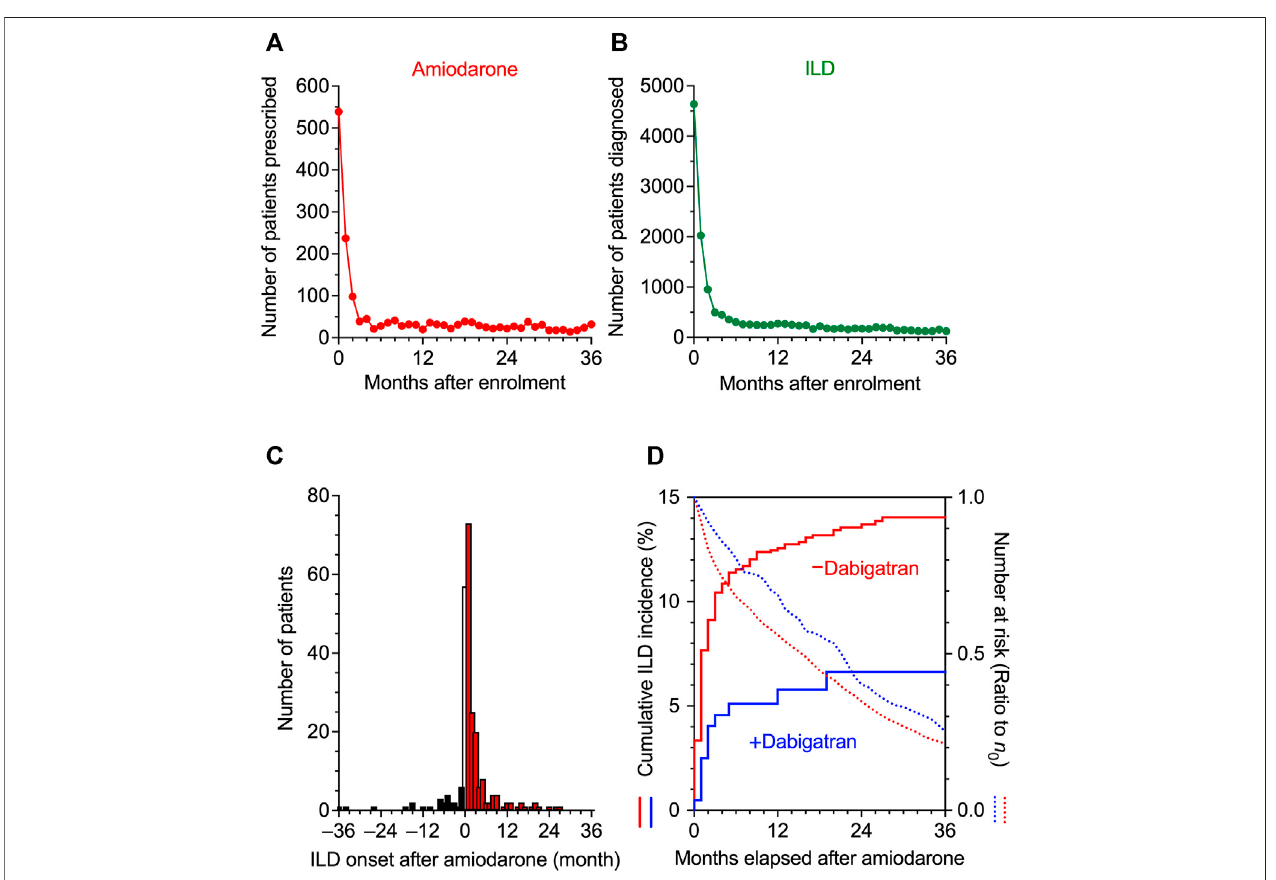
FIGURE2| Timedistribution oftheeventinJMDCclaims data. (A,B) ,Theintervalsfrom theinsuranceenrolmentofapatient tothe fi rstprescription ofamiodarone (A) and to the initial diagnosis ofinterstitial lung disease (ILD) (B) were analyzed, and the number of patientsis shown on a monthly basis. From these data, patients who hadbeenenrolledinhealthinsurancefor0 – 2 monthswereomittedinthefollowinganalysistoallowarun-inperiod. (C) ,Sequencesymmetryanalysisshowingthecausal relationship between the start of amiodarone treatment and the onset of ILD in an observation period of ± 36 months. At month 0, the precise chronological order was unknown, and the data were omitted from the analysis. (D) , Kaplan-Meier curves for the cumulative incidence ratio of ILD in patients taking amiodarone are shown individually in two populations, one without (red) and one with (blue) co-prescribed dabigatran. Dotted lines show the number of patients at risk as a ratio to the initial number ( n 0 ) of